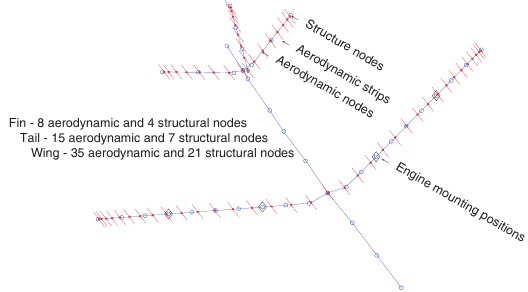
Fig. 6. Scheme of the AX-1 model aerodynamic and structural frames